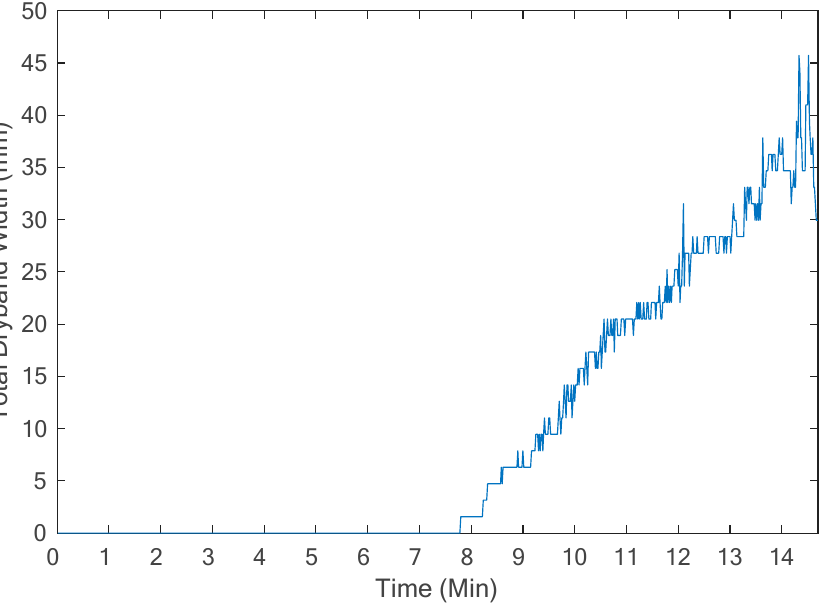
Figure A3. Total dry-band length. Ramp-test: Design CONV, ESDD = 0.42 mg/cm 2 , and a fog rate of 3 L/hr.